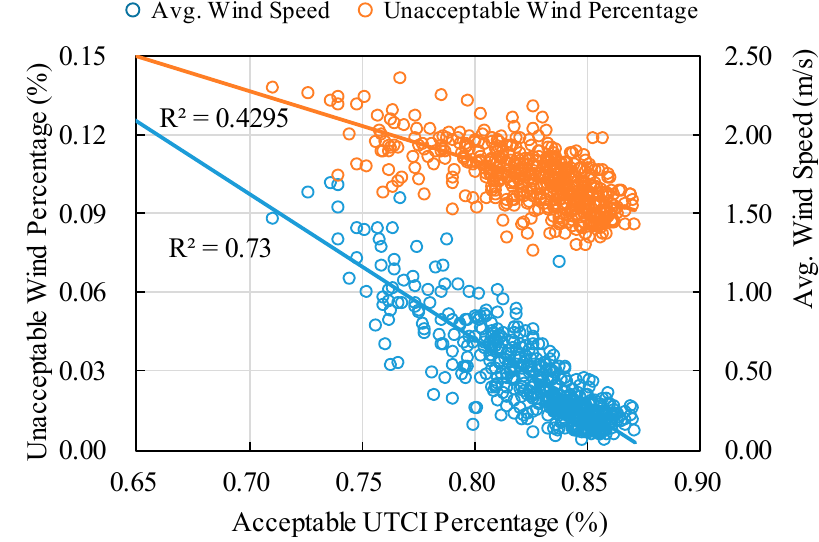
Figure 12. Correlation results of average unacceptable wind percentage, average wind speed, and acceptable UTCI percentage at block level.